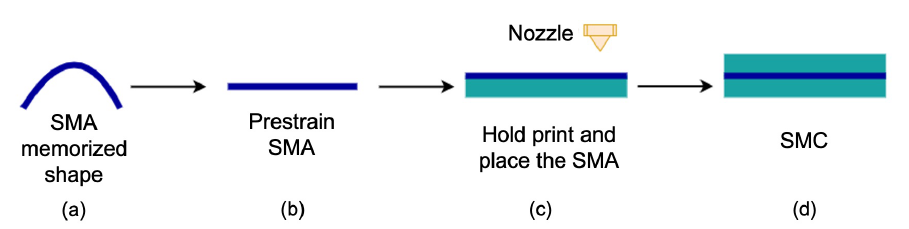
Figure 5. Schematic fabrication process of the SMC: prestrain the SMA wire from its memorised U shape using a mandrel or straightener ( a , b ); 3D print the SMP layers until the layer with grooves for placing the prestrained SMA ( c ); 3D print the rest of the SMP layers ( d ).